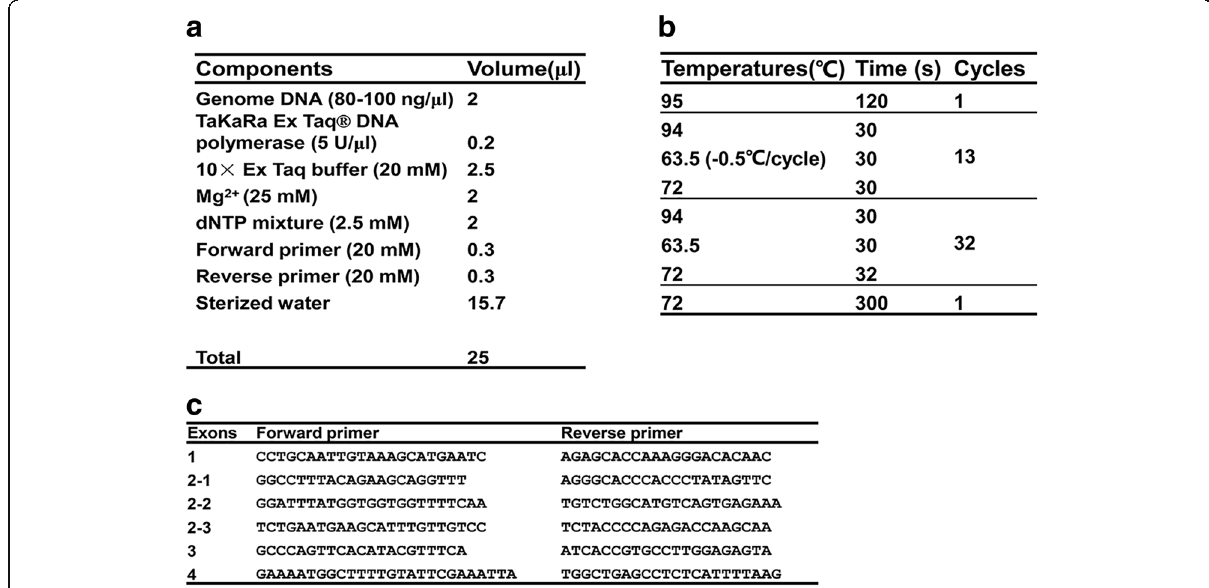
Fig. 1 The reagents, conditions and primers of PCR. a The components and volumes of PCR for BCHE gene. b The conditions of touchdown PCR. c The primer sequences of each exon of BCHE